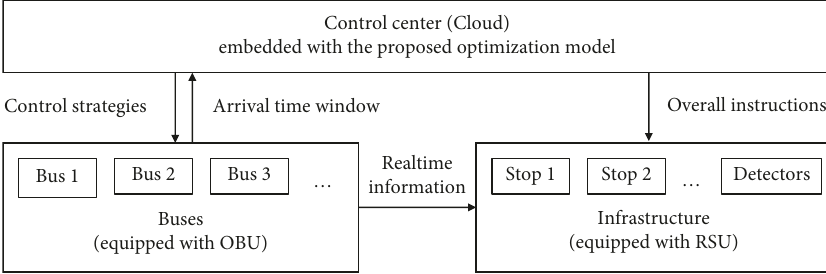
Figure 3: Control